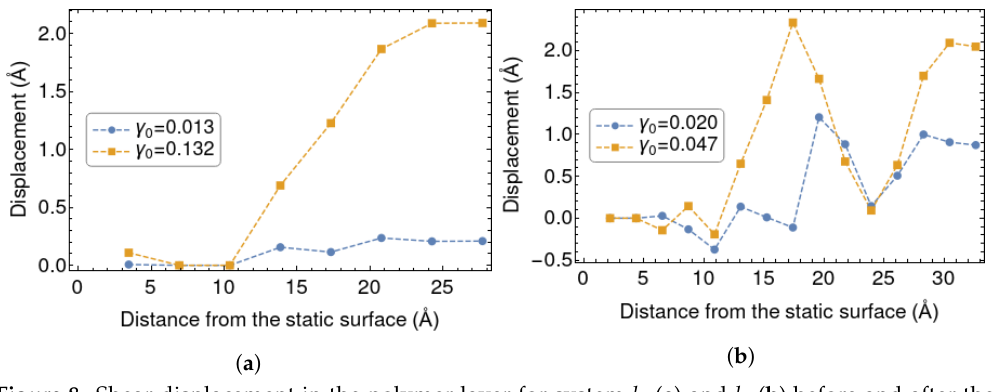
Figure 8. Shear displacement in the polymer layer for system l 1 ( a ) and l 2 ( b ) before and after the drop in G’ at the maximum γ reached during the DMA. On the x axis there is the distance from the static surface, on the y axis there is the average lateral displacement of the atoms belonging to a certain